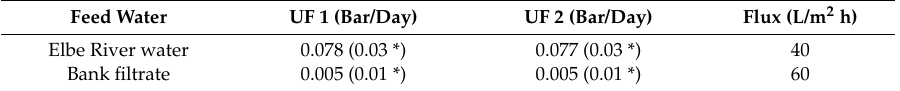
Table 2. A comparison of the fouling potential of both membrane types with differentiated